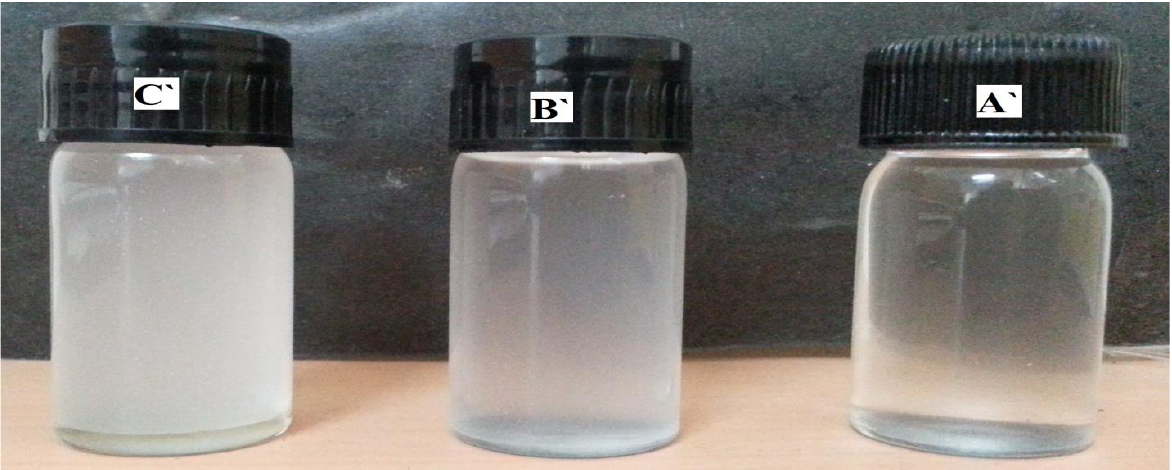
Figure 2. Phase diagram for alginate sol/hexane/Span 20 microemulsions. Squares ( ), circles ( )